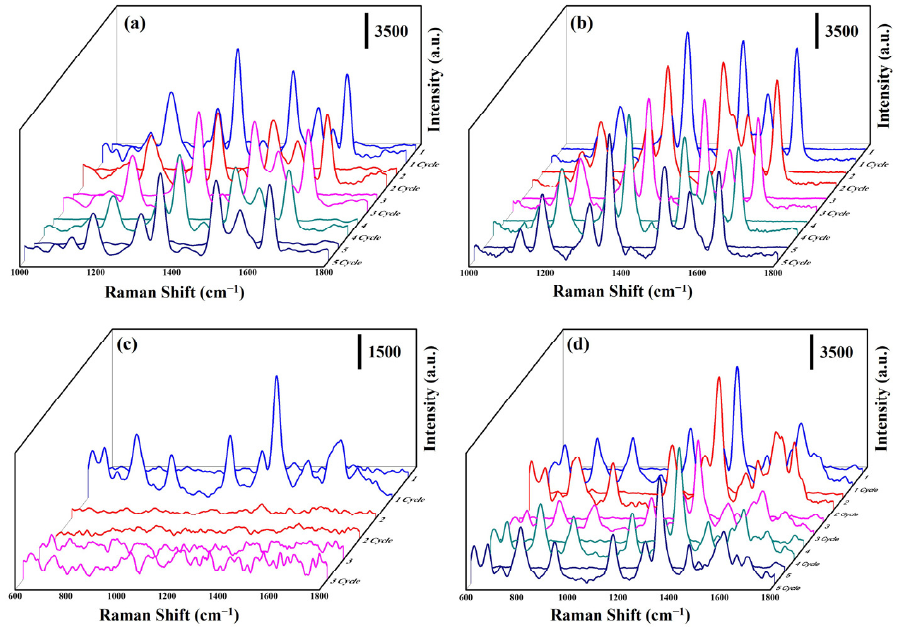
Figure 9. SERS spectra of (10 − 6 M) R6G solution on ( a ) ZnO: Ga@Ag nanotowers and ( b ) ZnO: Ga@ITO@Ag nanotowers at the five cycles. SERS spectra of (10 − 3 and 10 − 6 M) amoxicillin solution on ( c ) ZnO: Ga@Ag nanotowers and ( d ) ZnO: Ga@ITO@Ag nanotowers at the five cycles.